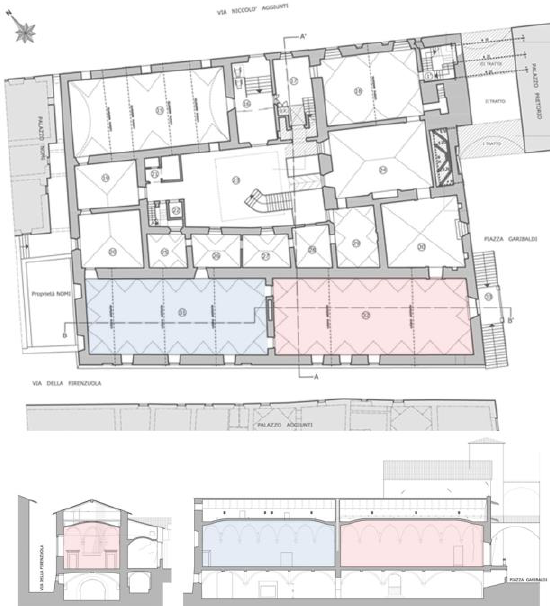
Figure 2. Survey of the Civic Museum of Sansepolcro. In red, the hall of the painting by Piero della Francesca; in blue the hall of Matteo di Giovanni; in the middle the wall that holds the painting. (Survey provided by the Municipality of Sansepolcro). The current roof was built in 1967. This roof is made with trusses formed by "Varese" joists in prefabricated reinforced concrete and steel chains. In 2017, a consolidation of the